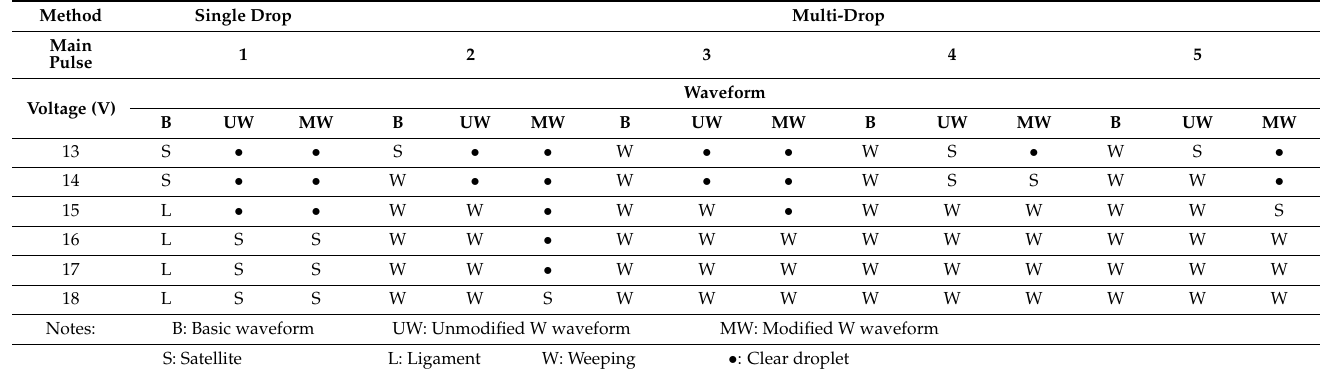
Table 3. Comparison of the generated droplet with different waveform designs (standard/basic waveform, unmodified W, and modified W).